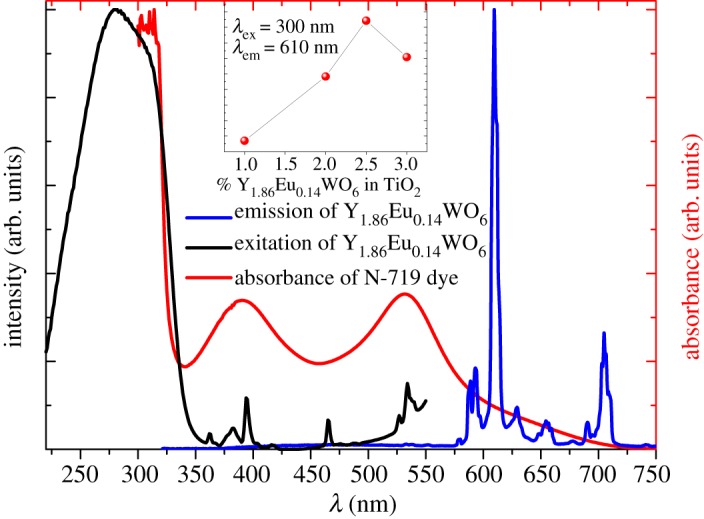
Excitation and emission spectra of Y1.86Eu0.14WO6 compared with the absorbance of N-719 dye.